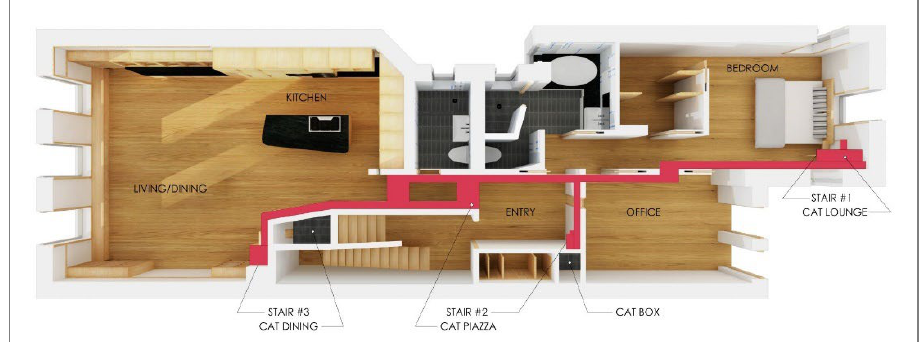
Figure 14 Small living space designed by “viaARCHITECTS”